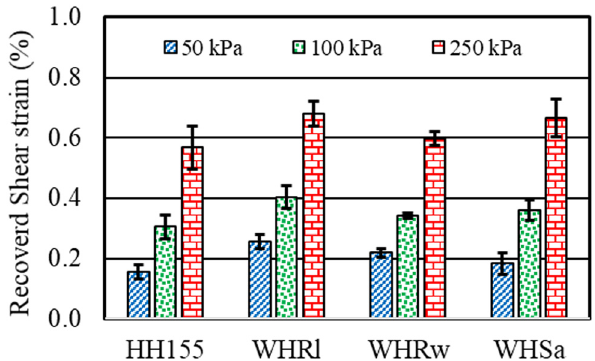
Figure 7: Recovered shear strain at each testing cycle of WMAs manufactured at 135°C.